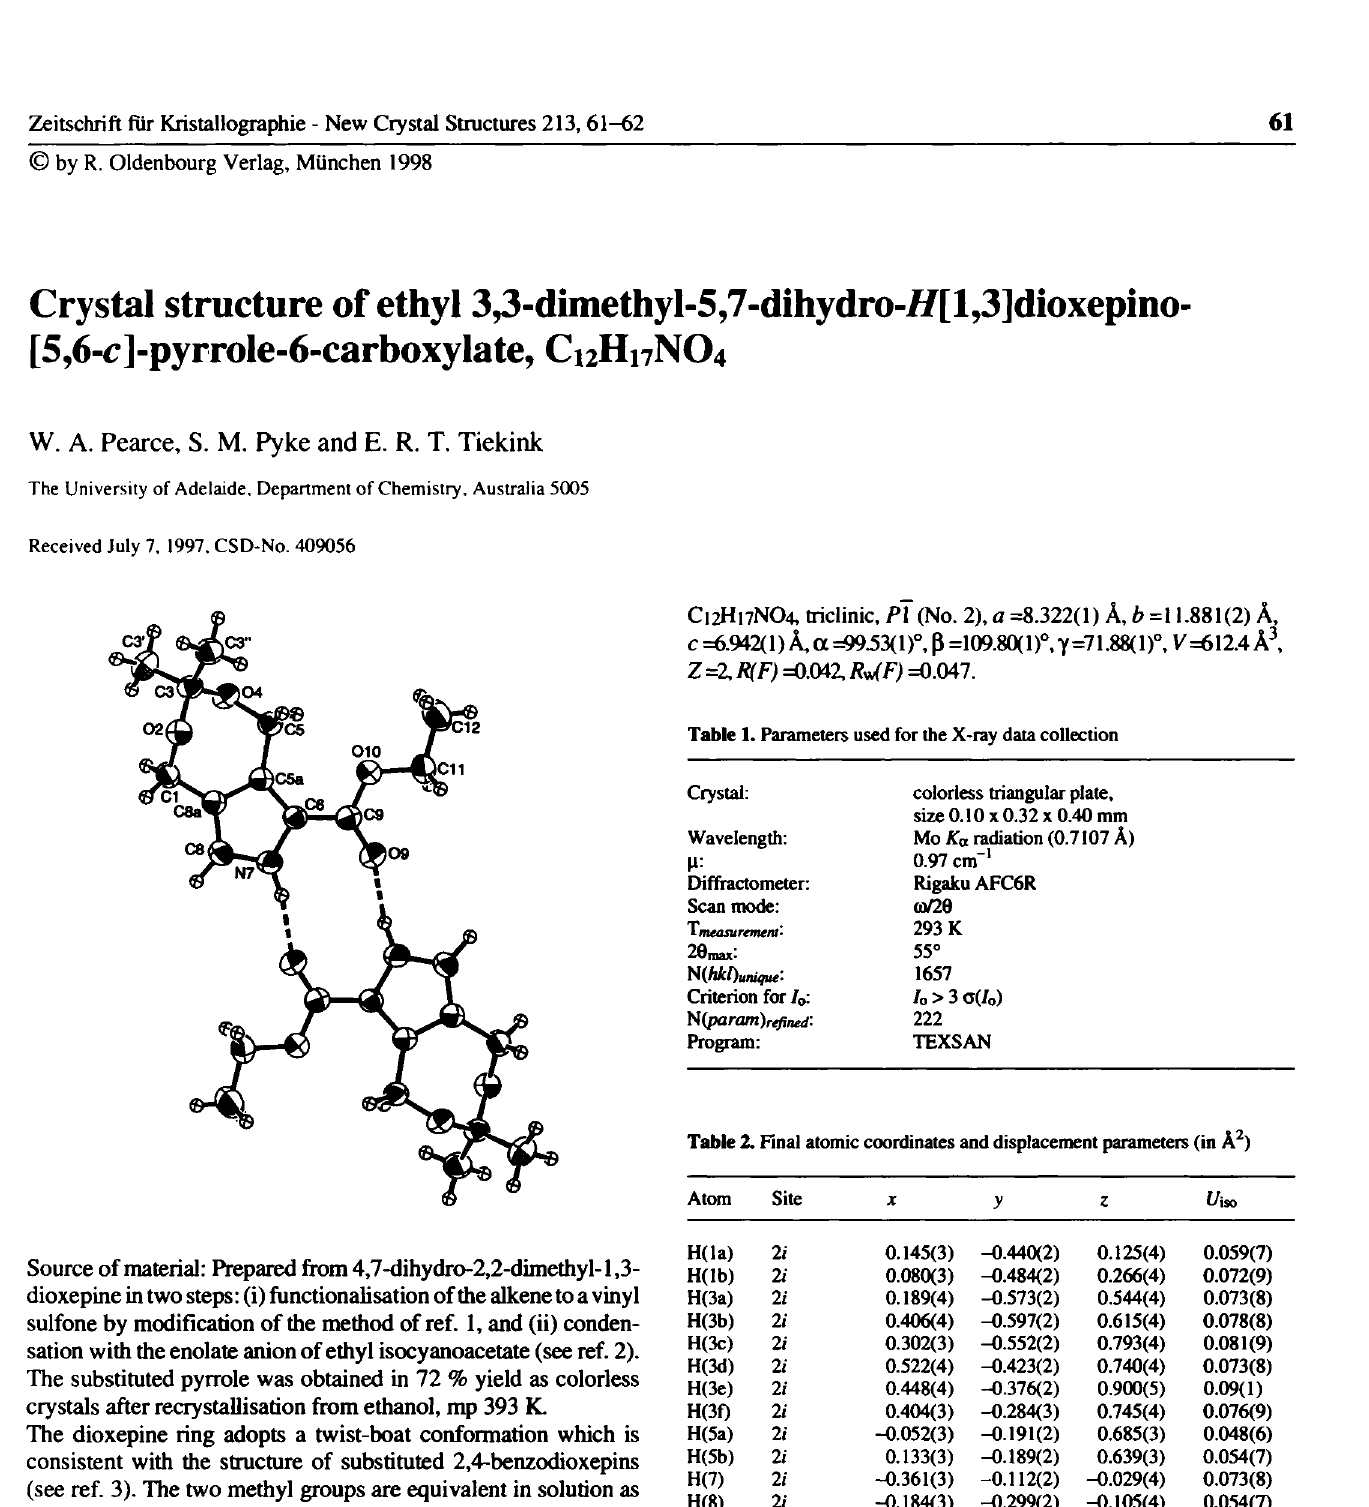
Table 3. Final atomic coordinates and displacement parameters (in Â^) Atom